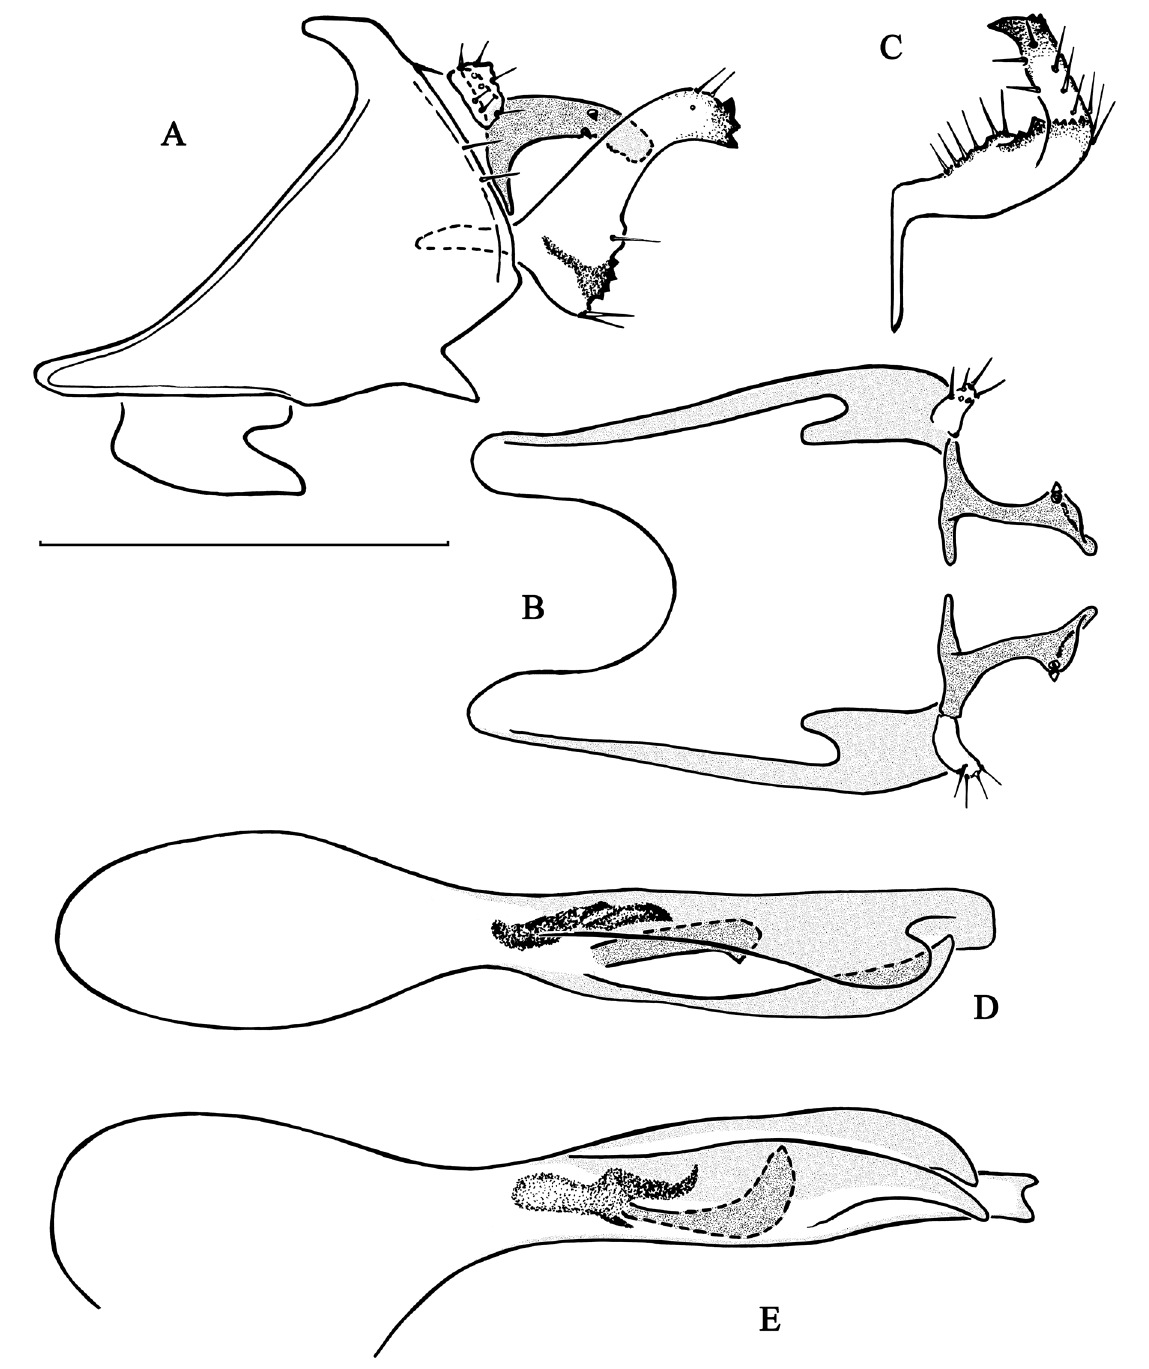
Fig. 9. Chimarra jejyorum sp. nov. A–B . Abdominal segments IX and X. A . Lateral view with ventral margin of sternite VIII. B . Dorsal view. C . Inferior appendage, dorsal view. D–E . Phallic apparatus. D . Dorsal view. E . Lateral view. Scale bar = 0.5